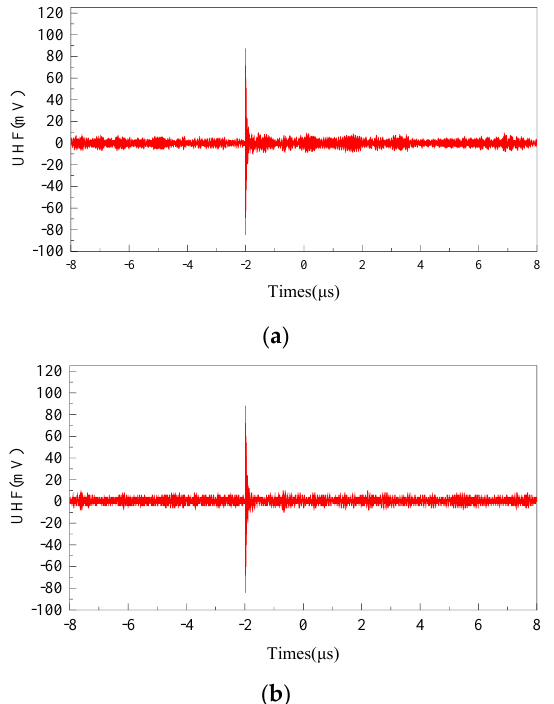
Figure 19. Signal waveform of flexible antenna collected at two voltage levels: ( a ) 12.5 kV and ( b ) 13.6